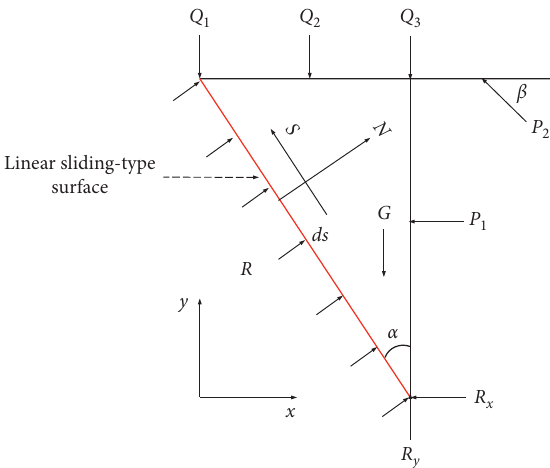
Figure 3: Mechanical model of sliding-type rib